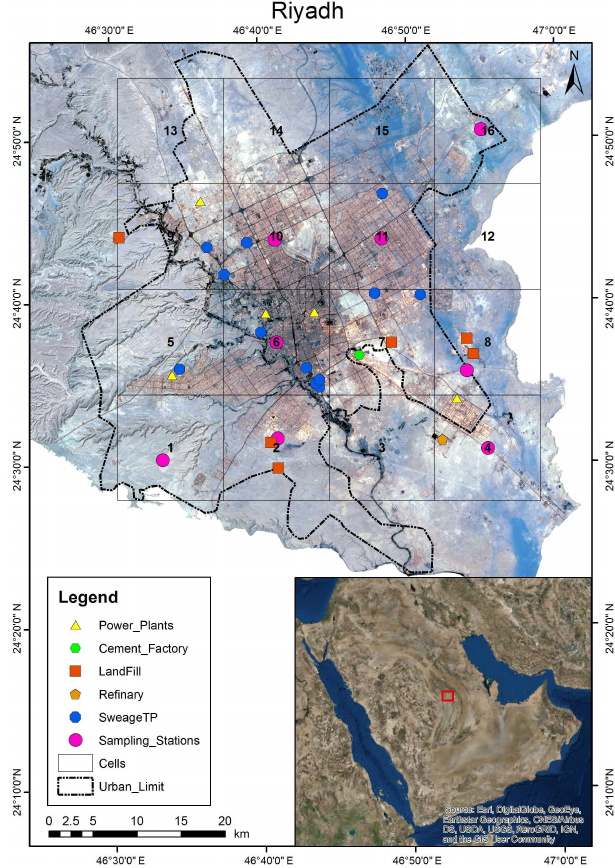
Figure 1. Image of Riyadh and immediate surroundings. Potential emission sources and 16 sampling locations are indicated. The char- acteristics of the sampling locations are listed in Table